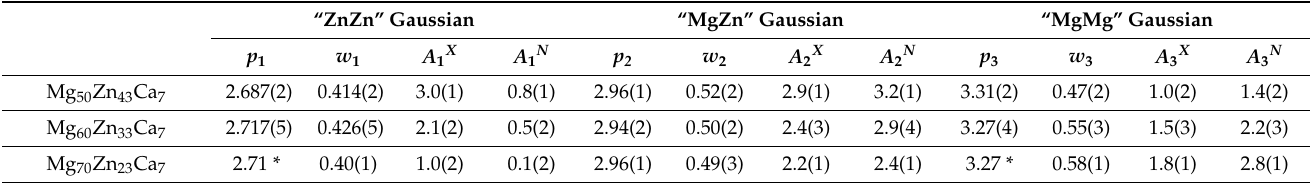
Table 4. Fitted Gaussian parameters representing ZnZn, MgZn, and MgMg pairs for Mg 50 Zn 43 Ca 7 , Mg 60 Zn 33 Ca 7 , and Mg 70 Zn 23 Ca 7 . Errors of individual parameters correspond to the fitting errors. “ZnZn” Gaussian “MgZn” Gaussian “MgMg” Gaussian